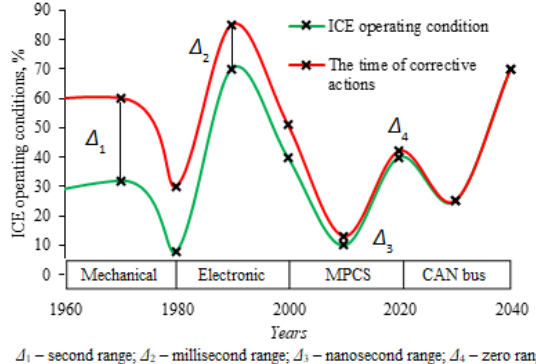
Figure 1. The dependence of the time of corrective actions on the ICE operating